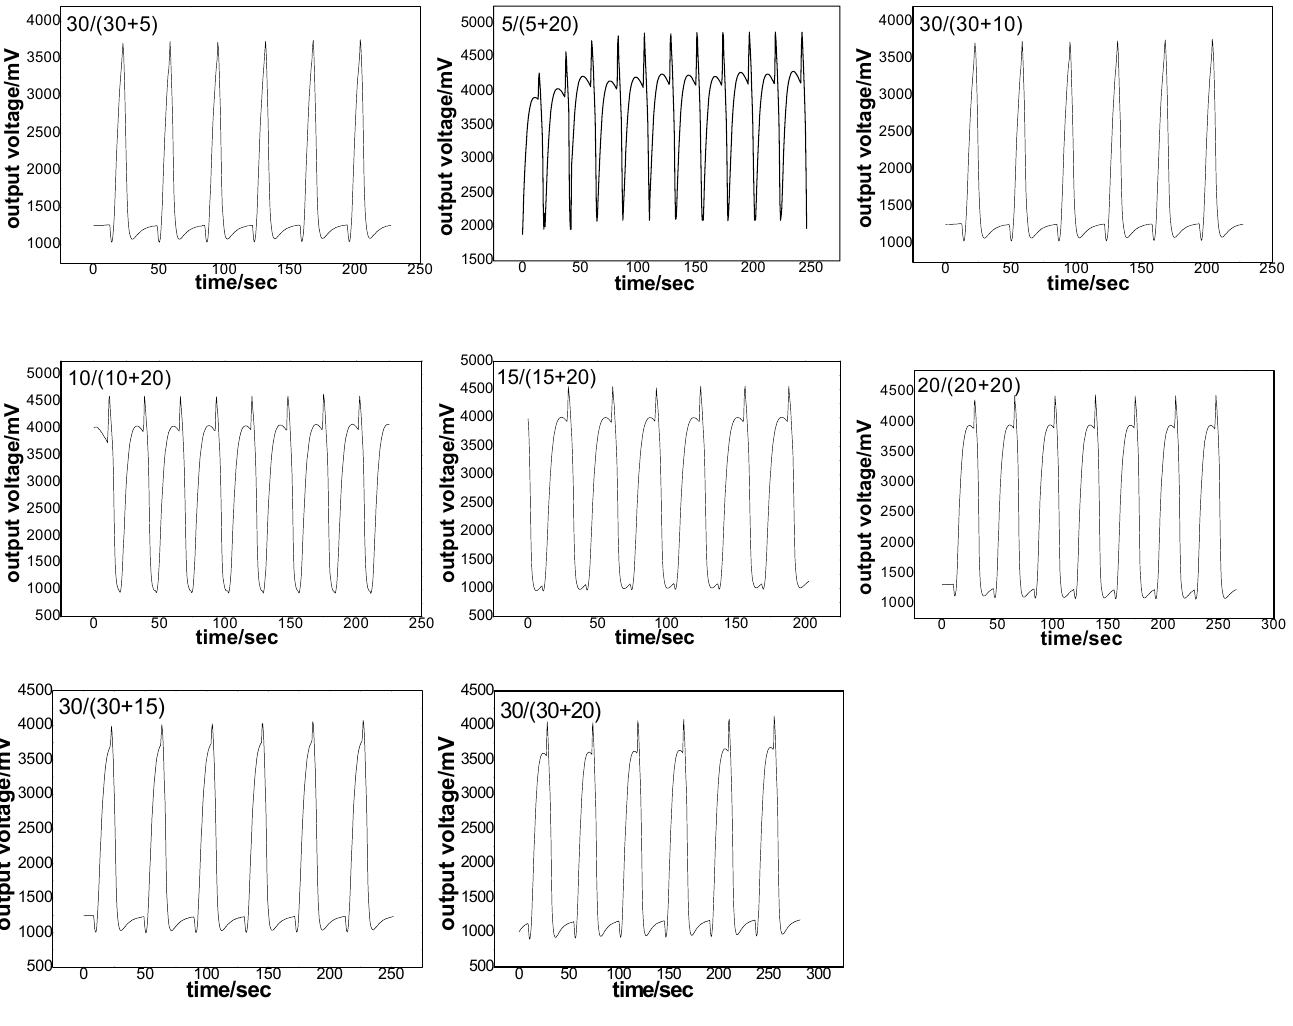
Figure 5. Effect of duty ratio on the responses to ethanol at an applied potential of 7 V in a rectangular